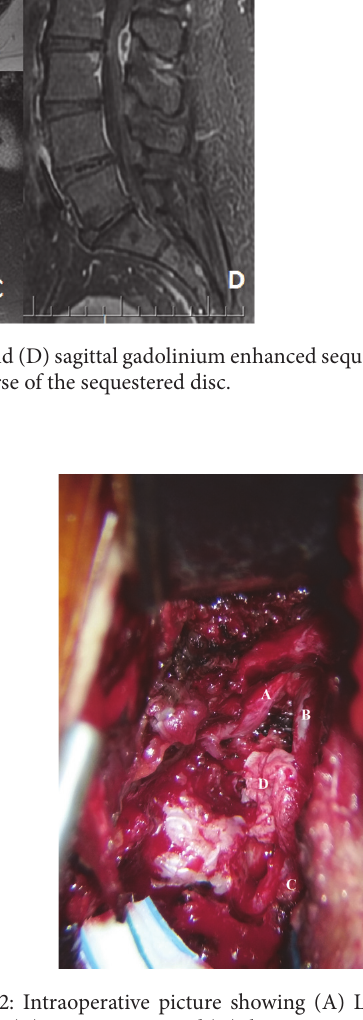
Figure 2: Intraoperative picture showing (A) L2 nerve root, (B) duralsac,(C)L3nerveroot,and(D)theposteriorextrudedsegment.